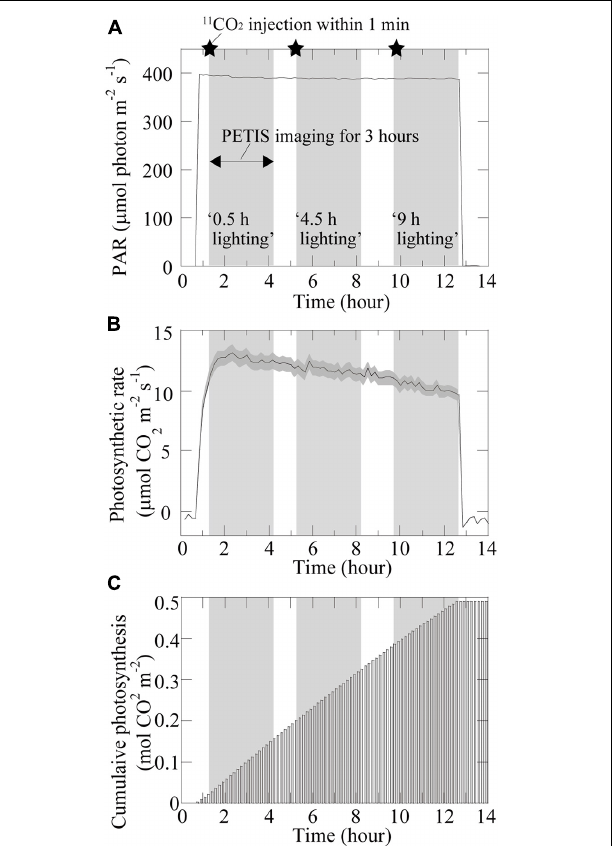
FIGURE 3 | Photosynthesis-related time changes. Time changes in (A) photosynthetically active radiation (PAR). The setup of the lighting treatments is also shown. The star symbol indicates the timing of the 11 CO 2 injection; (B) photosynthetic rate; and (C) accumulated photosynthesis in the source leaf under specific environmental conditions during PETIS imaging. The dark gray area in (B) represents the standard